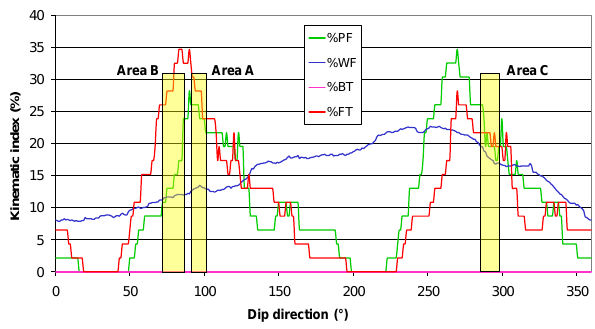
Fig. 14. Constant dip quantitative kinematic analysis for Mdina. Yellow rectangles indicate the dip direction range for each investi- gated area. (PF: plane failure; WF: wedge failure; BT: block top- pling; FT: flexural